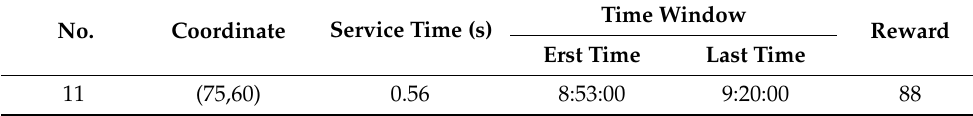
Table 6. Task Re-scheduling Schemes based on Buy-sell Contract to Deal with Emergency Table 5. Parameter of the Emergency Tasks.